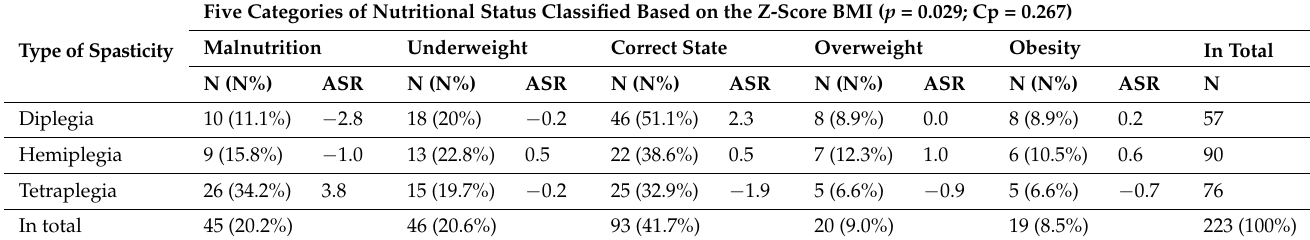
Table 13. Relationship between five categories of nutritional status and type of spasticity.